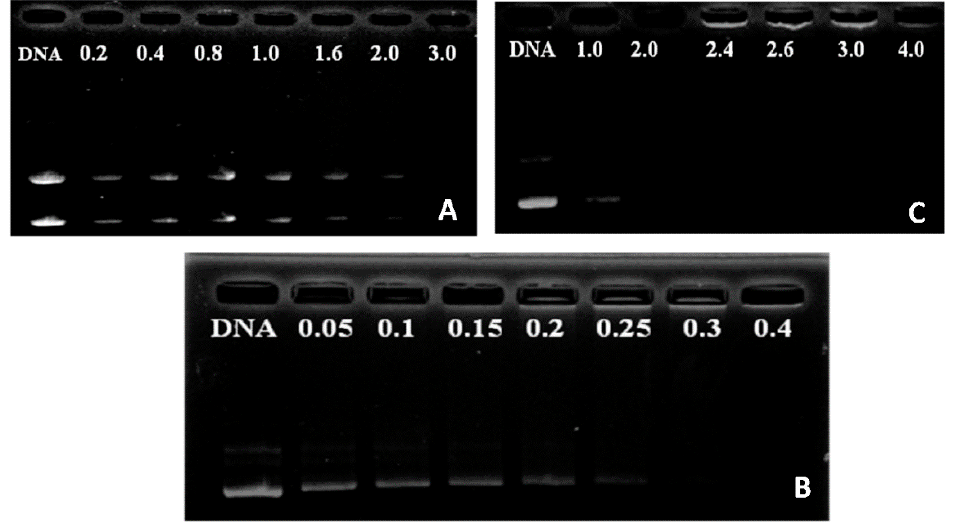
Figure 4. Agarose gel electrophoresis of the complexes at various polymer-to-pDNA w / w ratios: ( A ) P123-PEI-4/DNA; ( B ) P123-PEI-11/DNA; ( C ) P123-PEI-18/DNA).